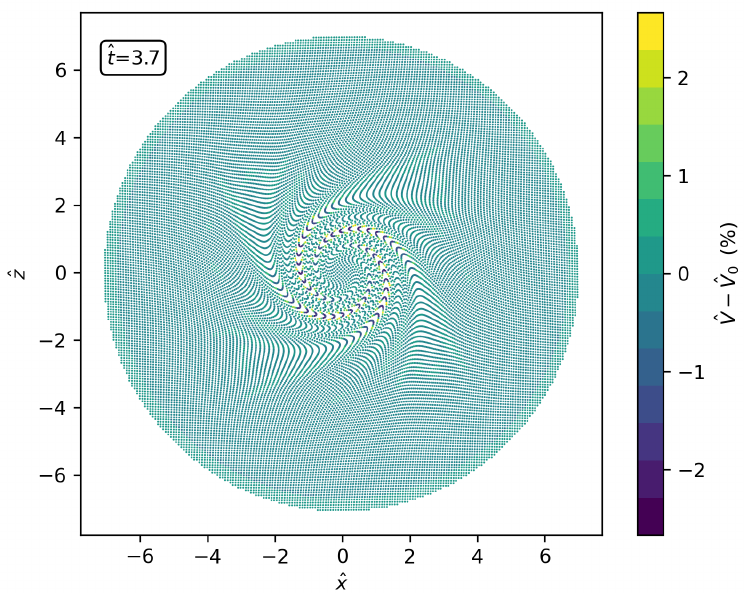
Figure 6. Distribution of particles at ˆ t = 3.7 for the 2D vortex case, with the field of unitary volume variation superimposed, computed by the RSPH-WENO scheme. The resolution is R / ∆ x = 92.